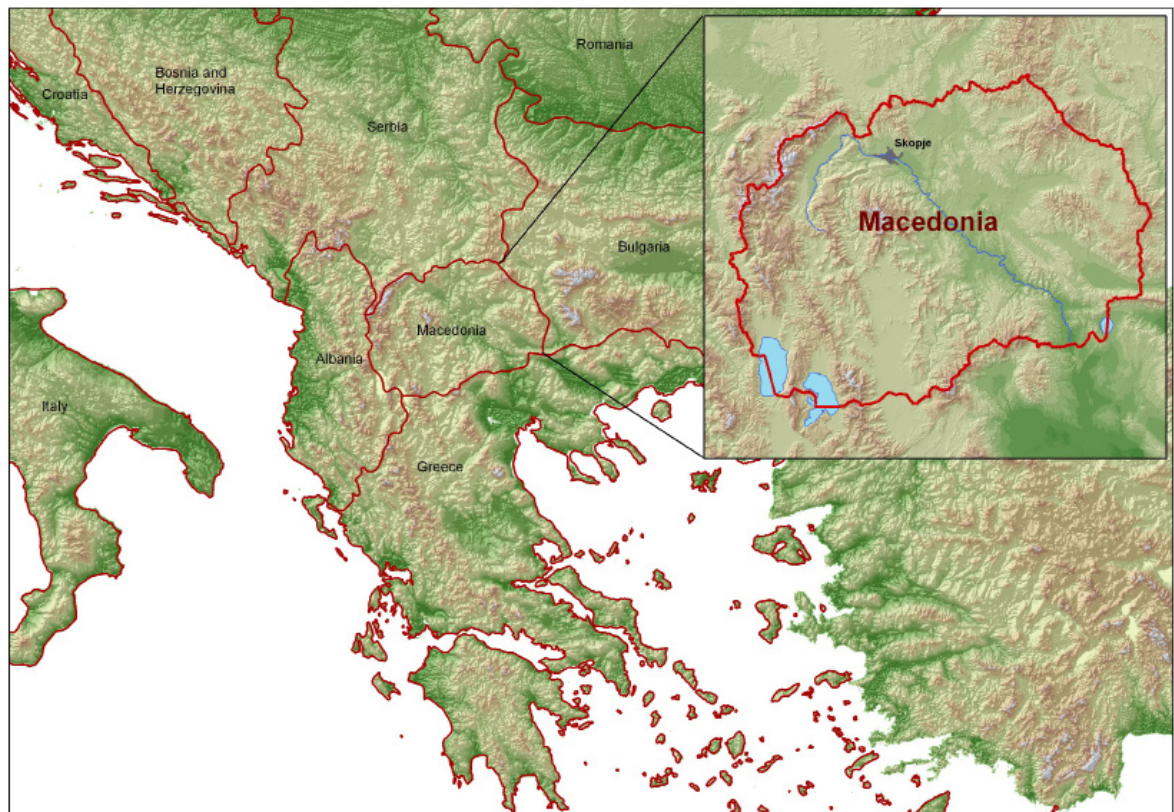
Figure 1. Republic of Macedonia and its position in the Balkan